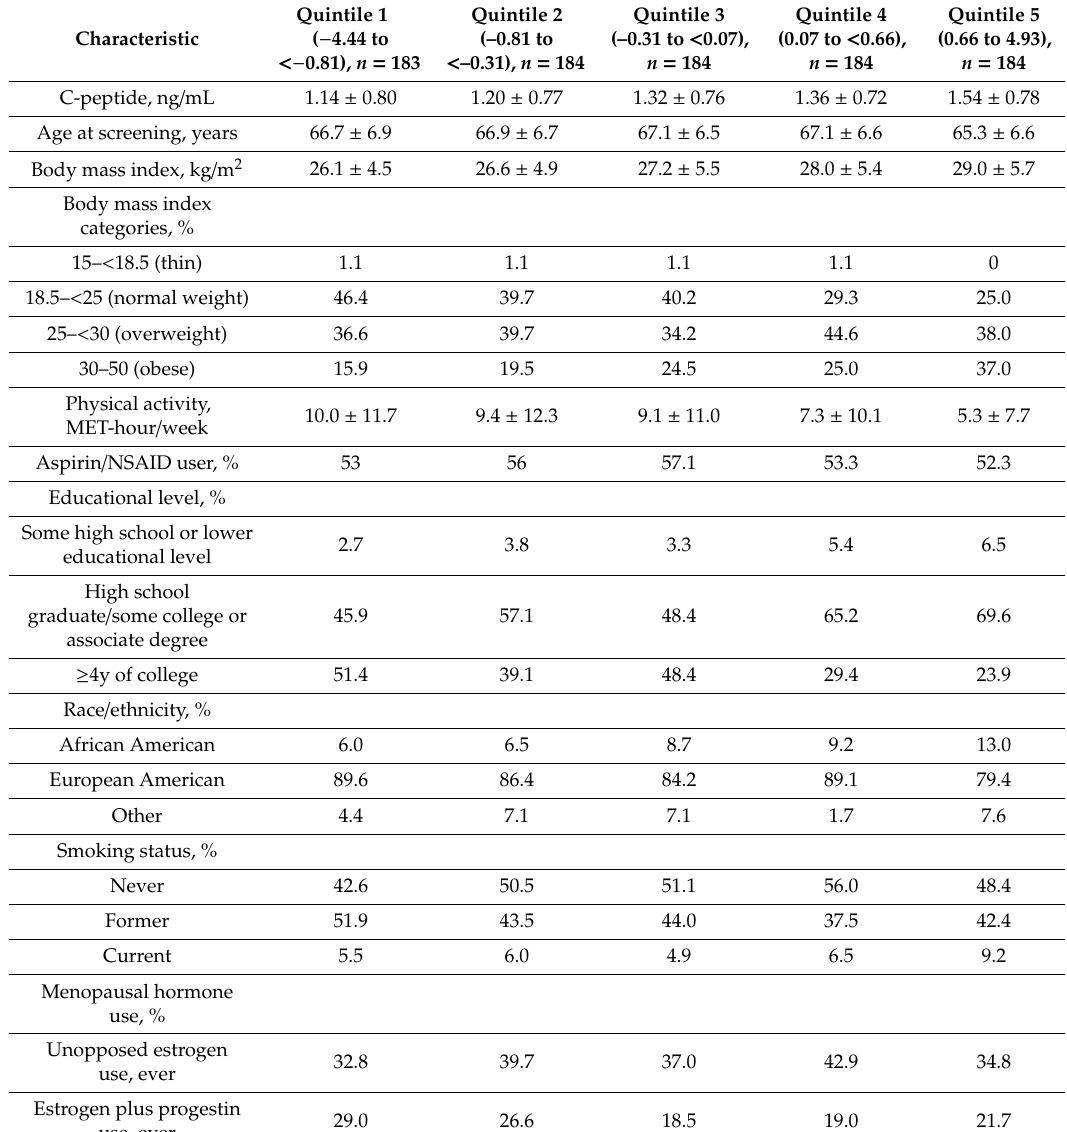
(Table 1). The Spearman correlation coe ffi cient between EDIH scores and c-peptide concentrations was 0.26, p < 0.0001, and the EDIH multivariable model explained 16% (r-square) of the variance in c-peptide. Table 1. Characteristics of the empirical dietary index for hyperinsulinemia (EDIH) score validation study population, n = 919 1,2